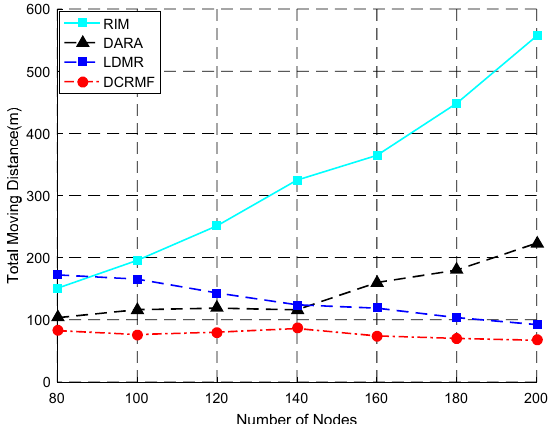
Figure 8. The relationship between the total moving distance and the total number of the nodes in the network by using these four algorithms.